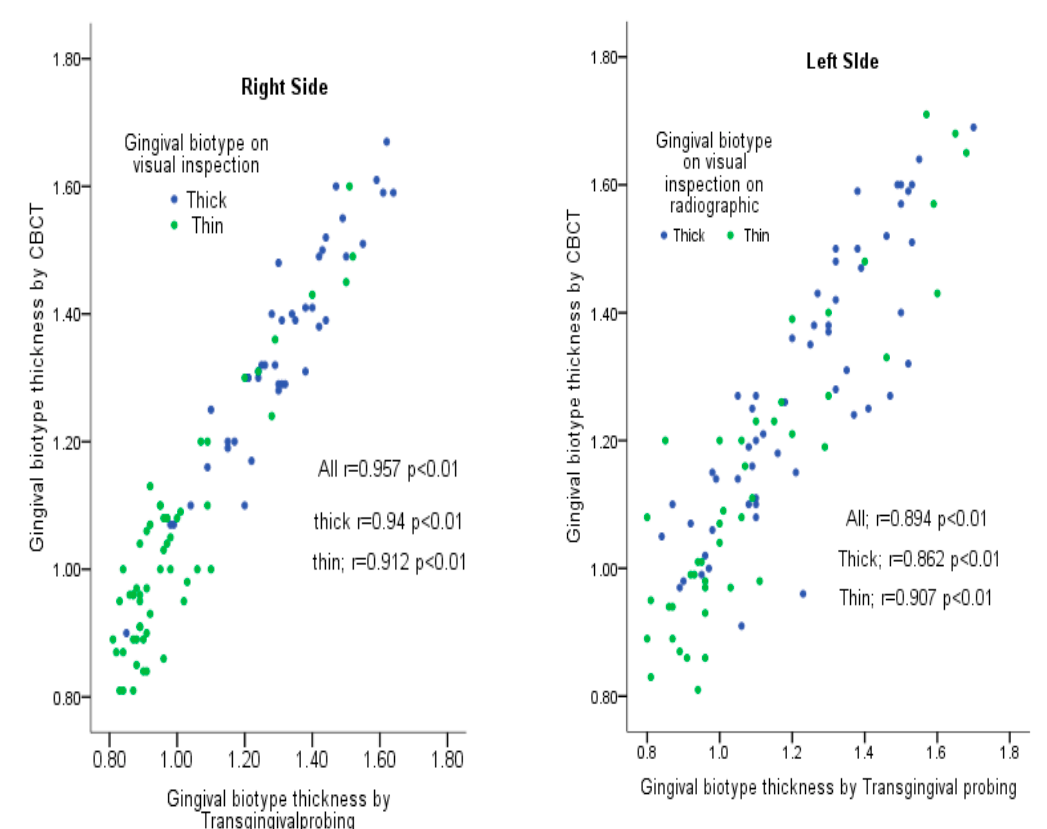
Figure 4. Correlation between different measurement methods.